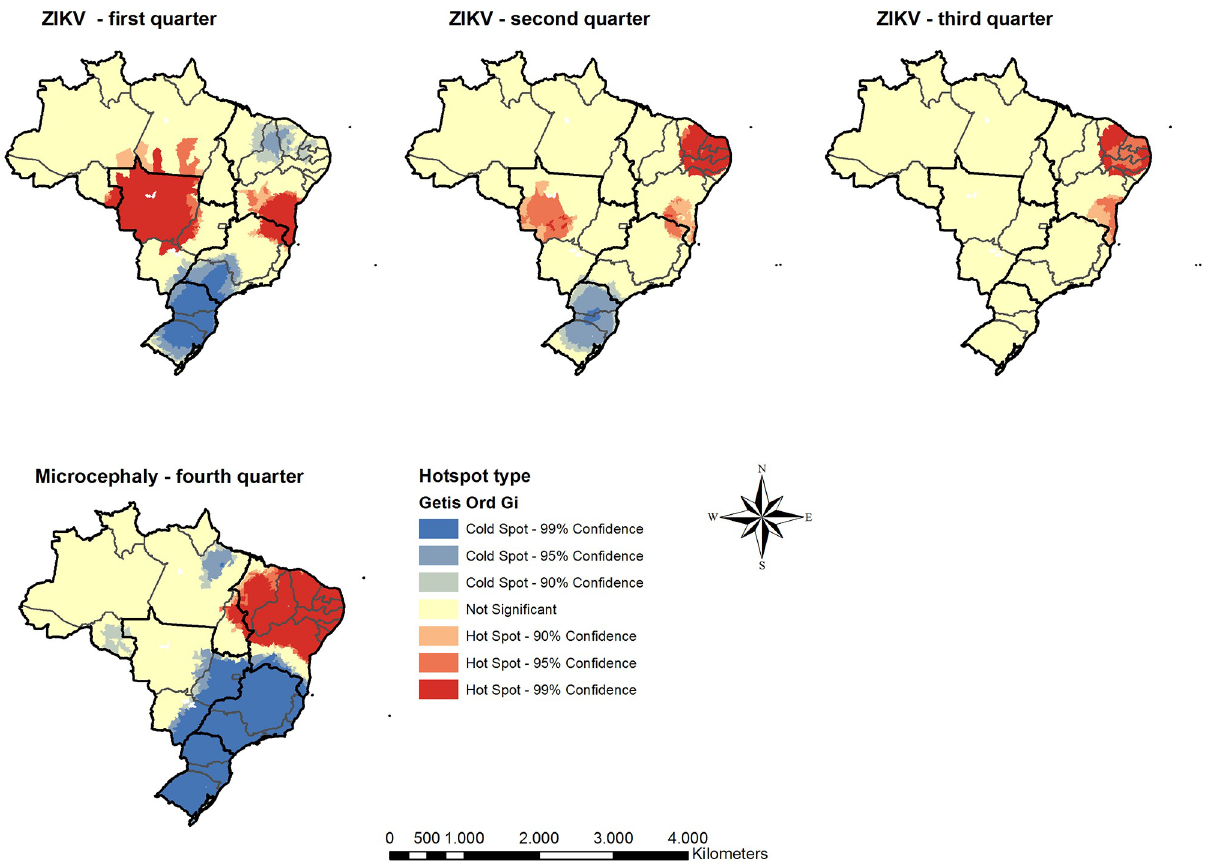
Fig 1. Spatial autocorrelation measured by Getis-Ord Gi of ZIKV and microcephaly, Brazil– 2016. Source: Own elaboration with SINAN, 2016 database.